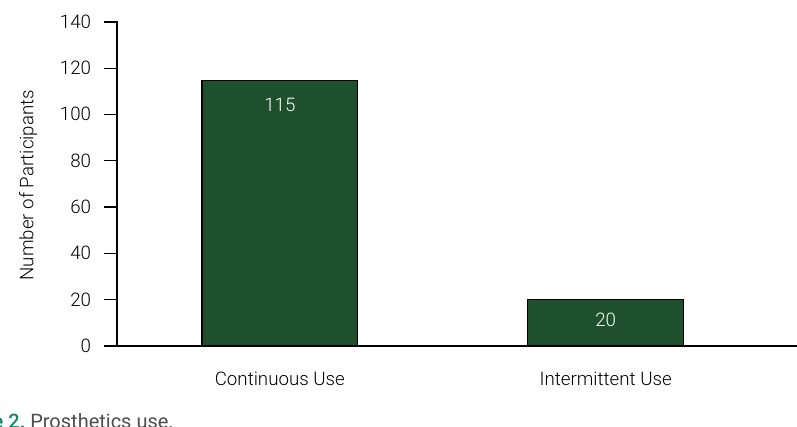
Figure 2. Prosthetics use.